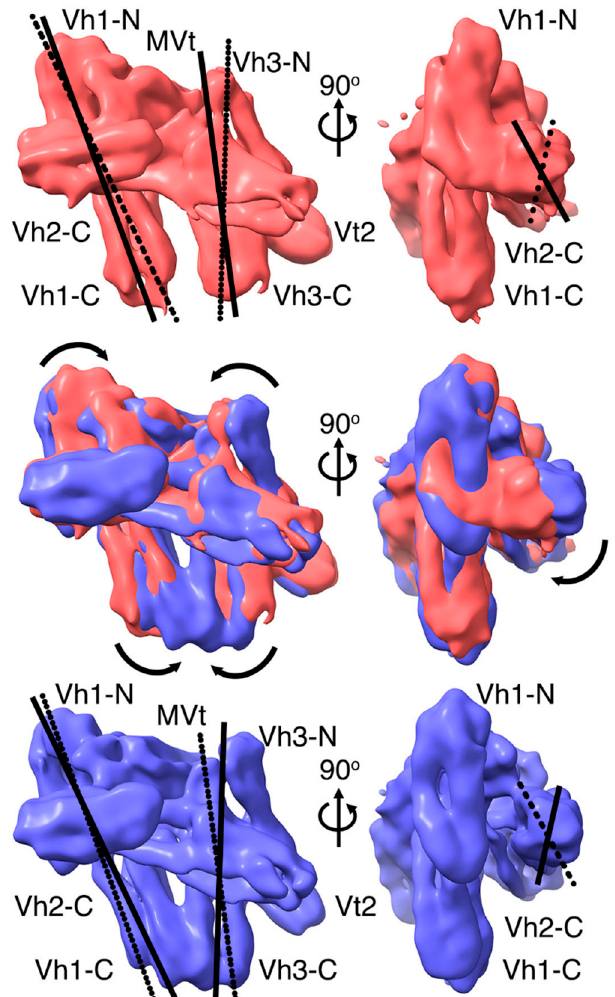
Figure 6. Conformational flexibility as determined by three-dimensional variability analyses. Three-dimensional variability analyses of metavinculin particles of the primed interface in the H1’-kinked state (red) and H1’-parallel state (blue) of metavinculin depicting the overall mobility of the various subdomains. The left panel show the prominent lateral movements of the Vh1 and Vh3 C-terminal four-helix bundles relative to each other. The right panels represent the 90 ° rotated view and illustrates the lateral movement of the Vh2 C-terminal four-helix bundle toward the Vh1 N-terminal four-helix bundle as a consequence of coordinated movement of rest of the four-helical bundles. The middle panels show the superposed view of the observed states with the top panel showing one of the states and the bottom panel showing the other state in opposite direction. The arrows indicate the direction of movement of individual subdomains, and the solid and dashed lines distinguish the lateral movements corresponding to each other. The various domains positions are labeled for clarity.